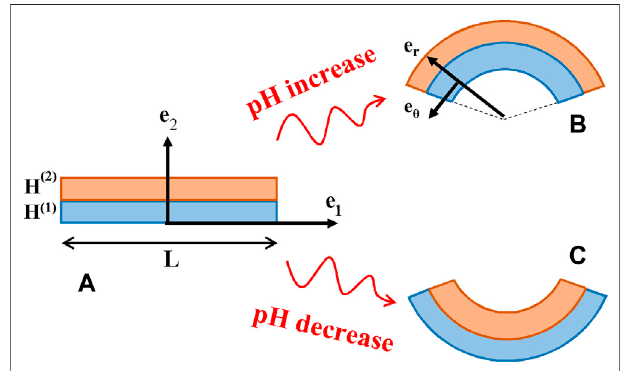
FIGURE 1| The schematics of the bilayer composed of poly (HEMA-co- AA) and poly (HEMA-co-DMAEMA) hydrogel at (A) the reference state, and the deformed state created by (B) an increase and (C) decrease in